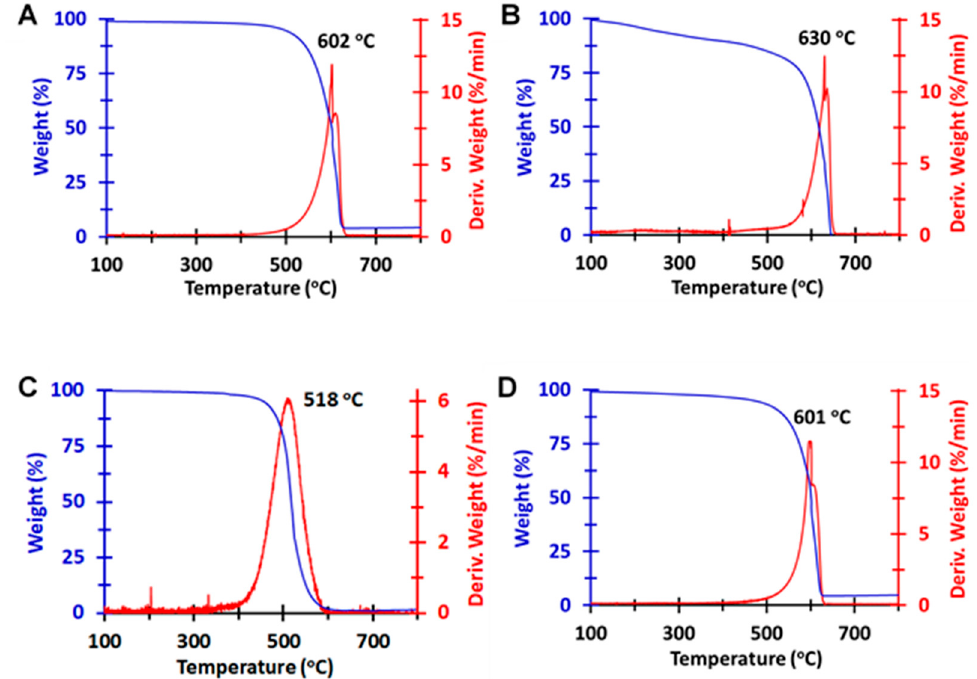
Figure 3. Representative thermograms (in air) showing the weight percent (blue) and derivative of weight percent (red) of the ( A ) 2015-pMWNT, ( B ) 2015-cMWNT, ( C ) 2018-pMWNT, and ( D ) 2018-cMWNT powders.